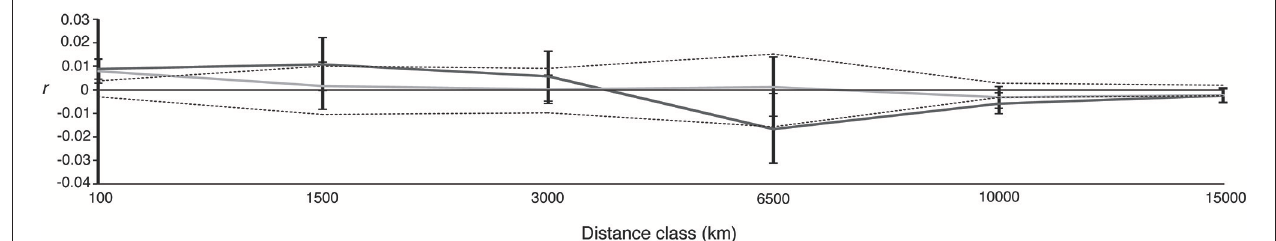
FIGURE 4 | Correlogram plot of the spatial autocorrelation coefficient, r , as a function of geographic distance for males (dark gray) and females (light gray). Black dotted lines represent the 95% confidence interval for the null hypothesis of no spatial structure ( r = 0) based on 10,000 random permutations of the data among distance classes. 95% confidence intervals about r were determined using 10,000 bootstrap replicates. Geographic distances (km) are the maximum distance of each